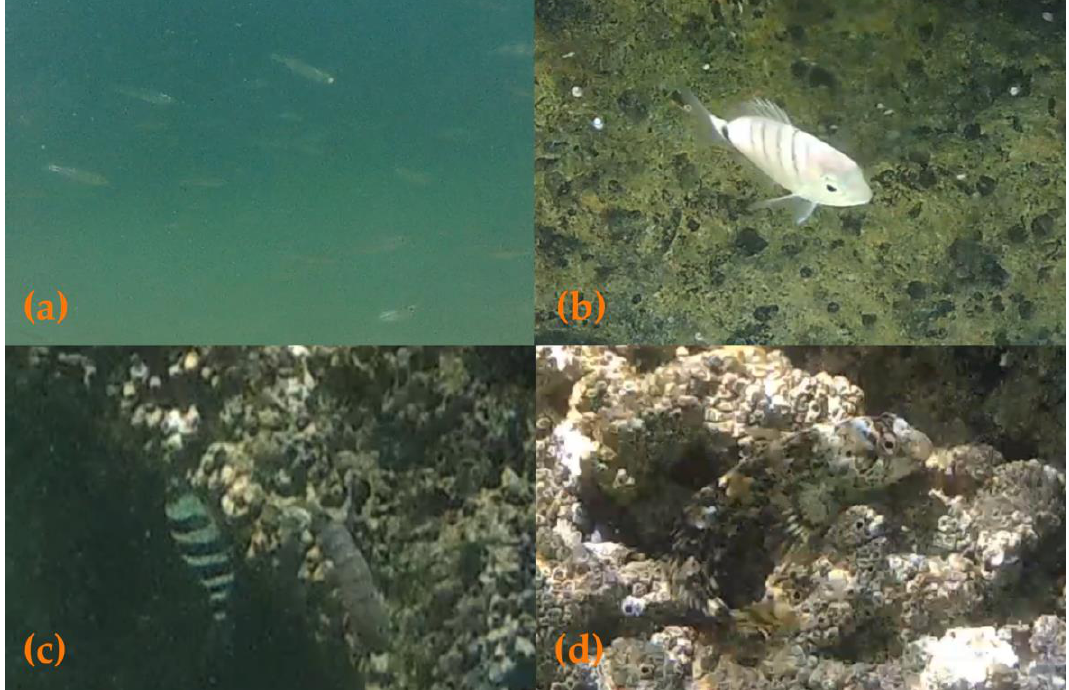
Figure 11. ( a ) Shoal of big-scale sand smelt ( Atherina boyeri Risso (1810)); ( b ) juvenile specimen of white seabream ( Diplodus cadenati de la Paz Bauchot and Daget (1974)); ( c ) specimen of zebra seabream ( Diplodus cervinus Lowe (1838)) feeding near the rocks and ( d ) a specimen of black goby ( Gobius niger Linnaeus (1758)) camouflaged on the rock.